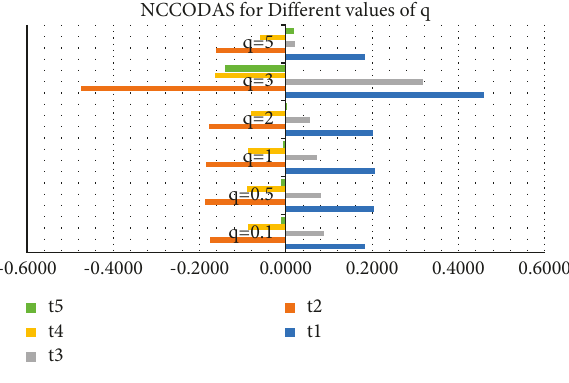
Figure 5: NCCODAS graphical view. Table 9: The tabulated view of comparative